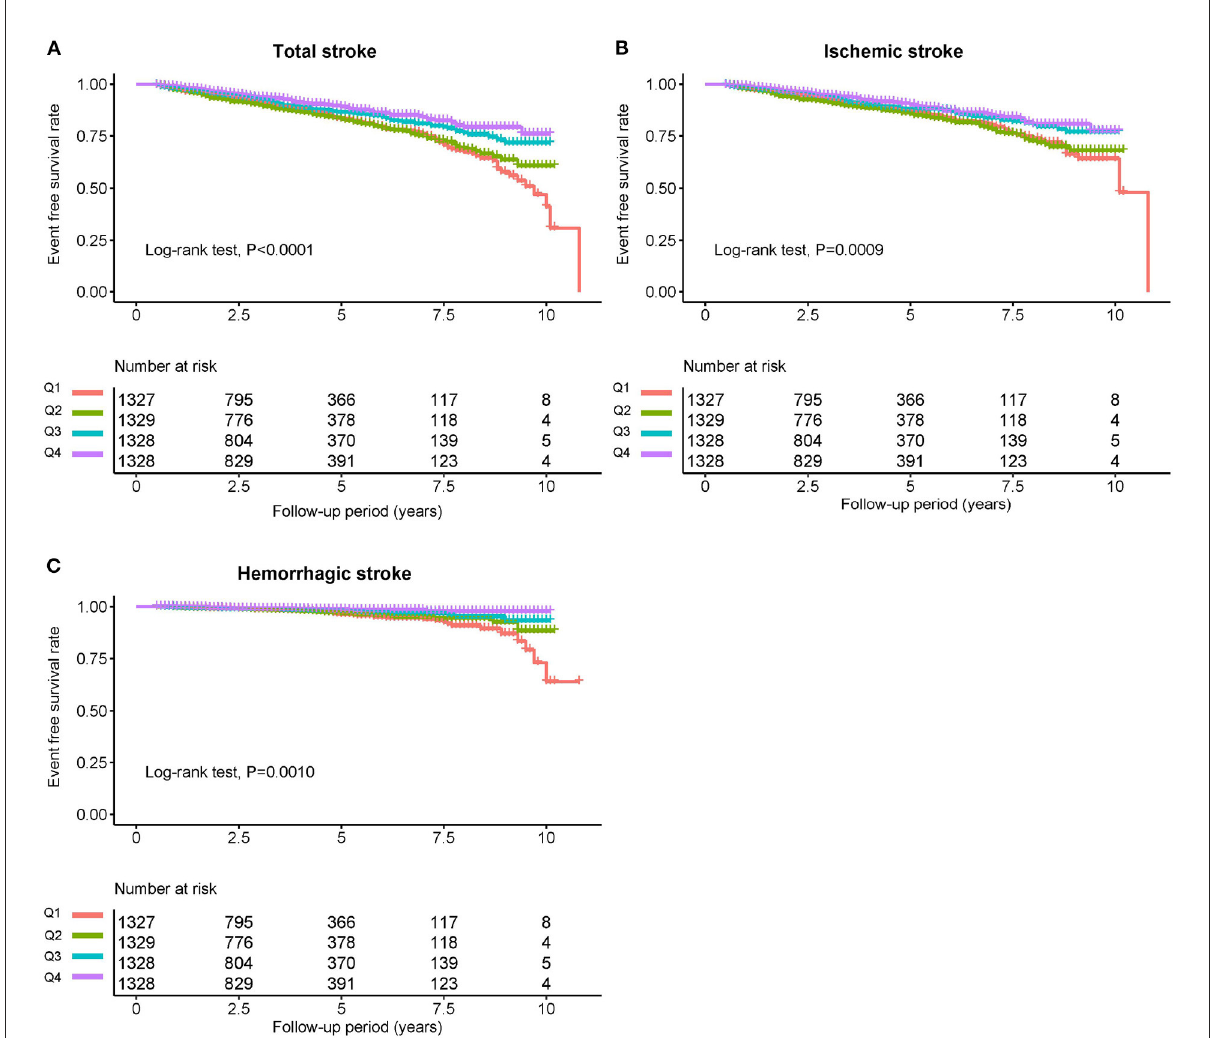
FIGURE3 Kaplan-Meier survival curves for total stroke and individual outcomes based on GNRI quartiles. (A) Total stroke, (B) ischemic stroke, and (C) hemorrhagic stroke.